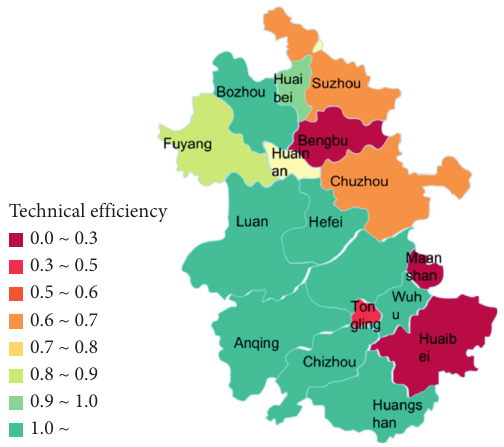
Figure 8: Technical efficiency 2019.